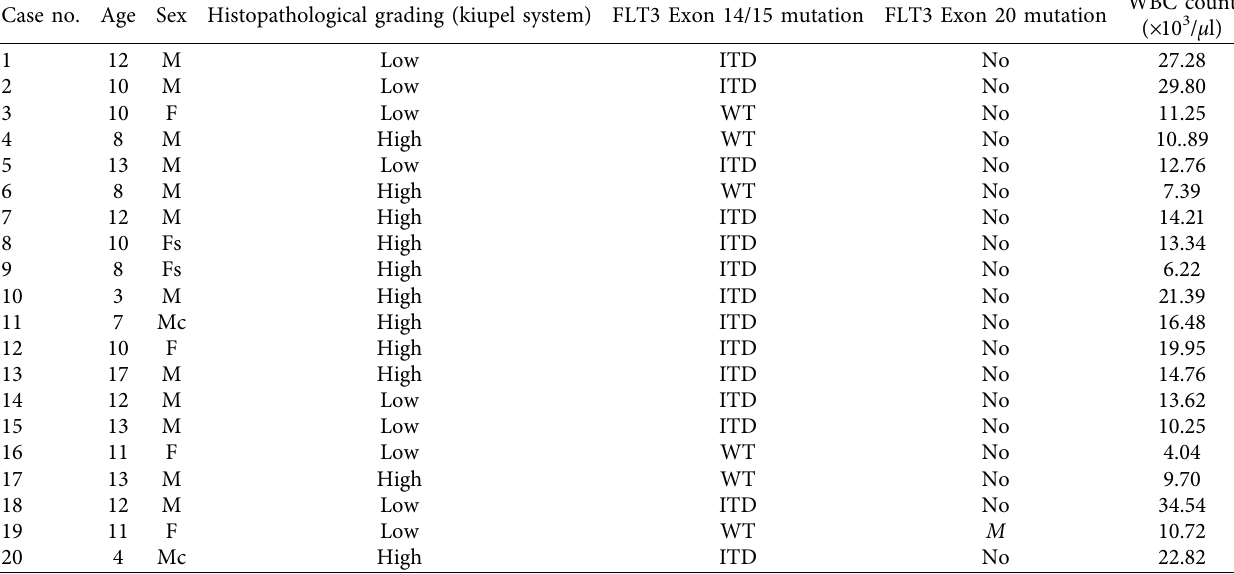
Table 2: Clinical information and FLT3 mutation status of 20 dogs with mast cell